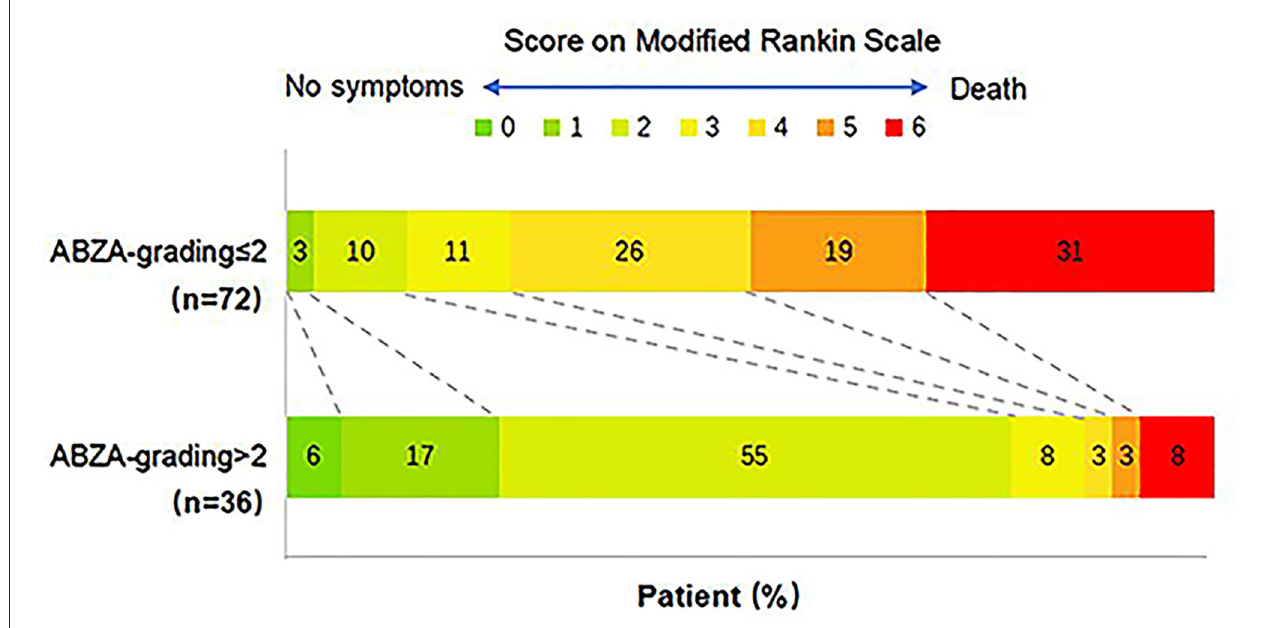
FIGURE 5 | Comparison of the 90-day functional outcomes stratified to ABZA-grading. ABZA-grading ≤ 2 was defined as poor colleral circulation, and ABZA-grading > 2 was defined as excellent collateral circulation. Among them, the cases of mRS ≤ 2 were 9 (13%) and 28 (78%), respectively. Contingency table analysis showed that there were significant differences in mRS score between ABZA-grading subgroups ( P < 0.001). mRS scores ranged from 0 to 6, with 0 indicating asymptomatic, 1 non-clinically significant disability, 2 mild disability (patients can take care of their own affairs, but cannot carry out all previous activities), 3 moderate disability (patients need some help but can walk independently), 4 severe disability (patients cannot walk independently, cannot take care of their own physical needs), 5 Severe disability (patients need continuous care), 6